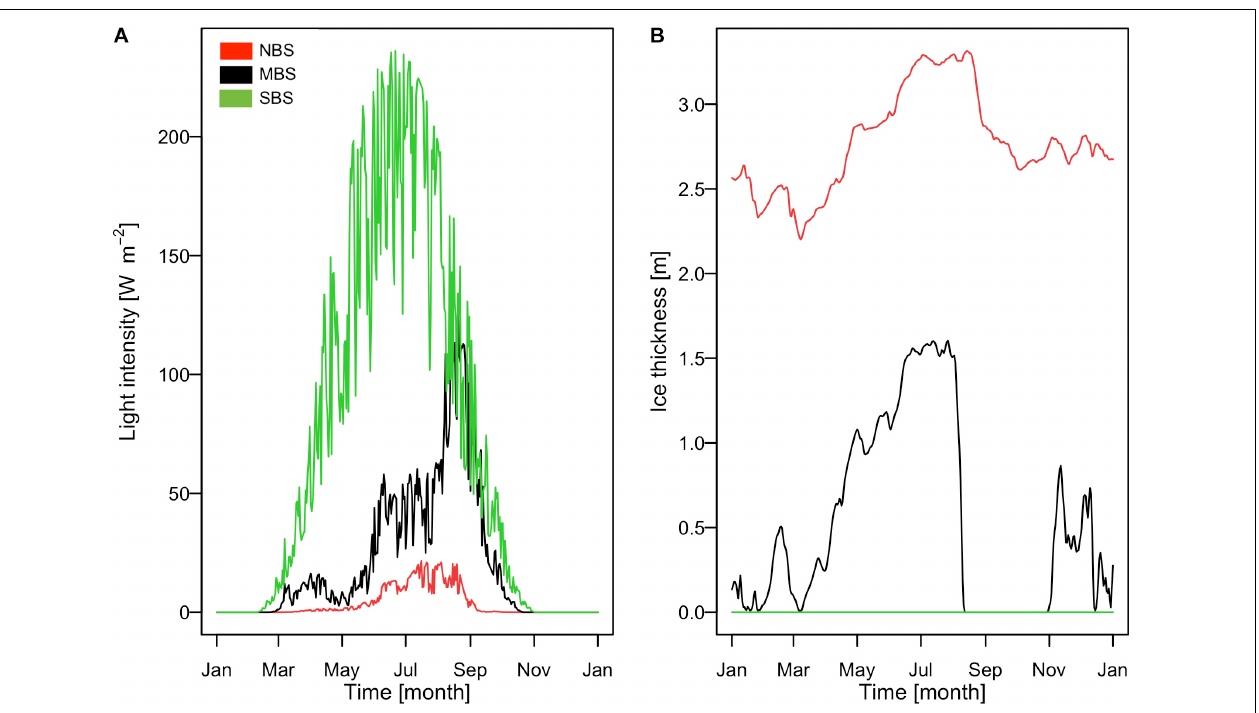
FIGURE 7 | Simulated time series of (A) light intensity (W m − 2 ) at the ocean surface (includes ice and ice algae attenuation) and (B) extracted sea ice thickness (m) forcing. Black color presents result for the central Barents Sea station over the 1997, red color for the north Barents Sea station over the 1997, and green color for the south Barents Sea station over the